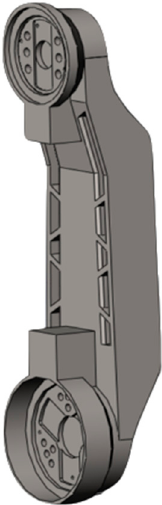
Figure 2. Original model of the upper arm.